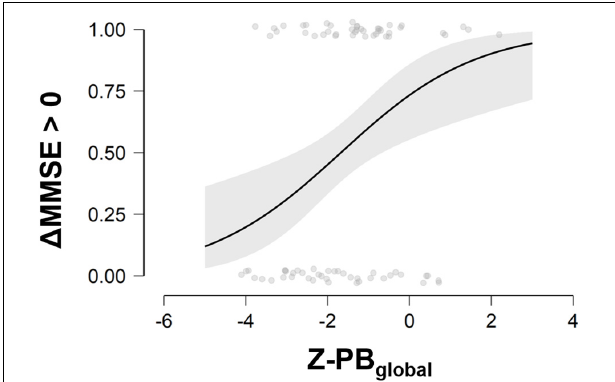
TABLE 4 | Binary logistic regression model to test best predictors of the MMSE change after rehabilitation. β S.E. Wald p-value Exp( β ) 95% C.I. for Exp( β )